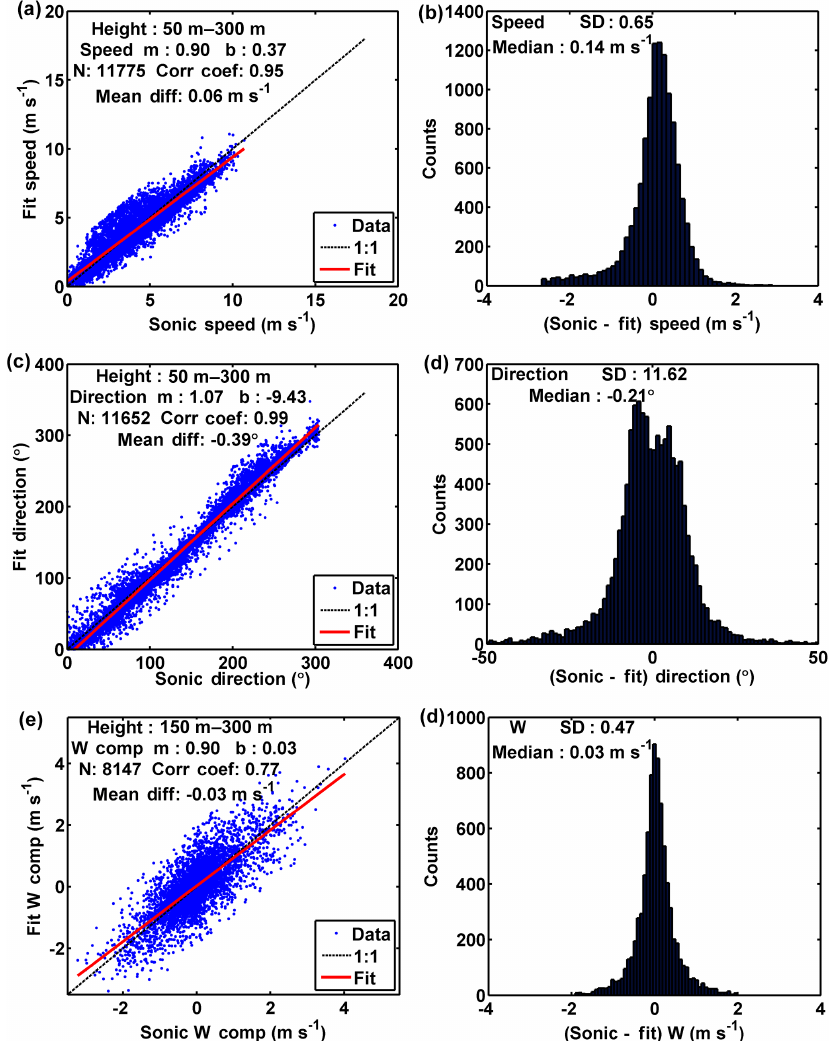
Figure 10. Comparison of the (a, b) wind speed, (c, d) wind direction and (e, f) vertical velocity measurements from the uncoordinated virtual tower technique with the measurements made by the sonic anemometer.